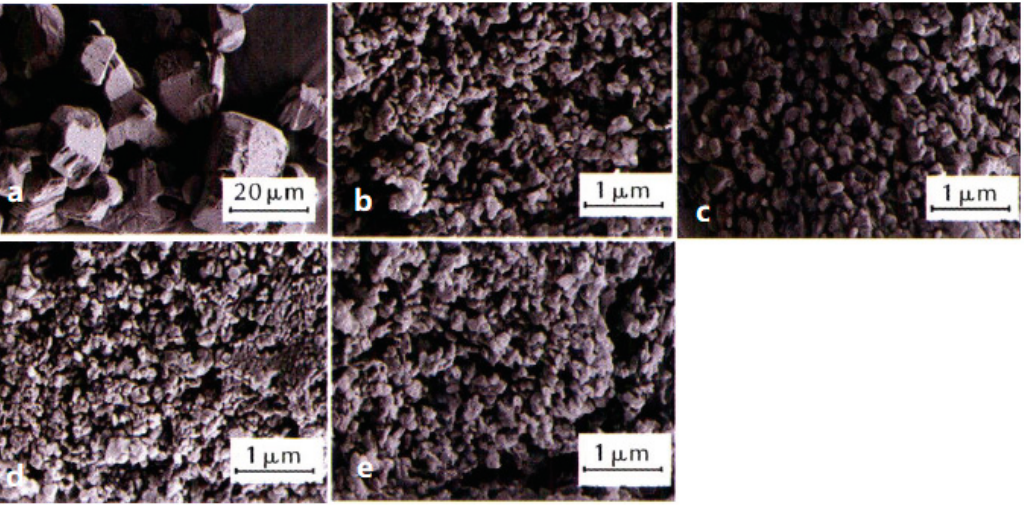
Figure 7. SEM images and average particle size of raw FOX ‐ 7 and nFOX ‐ 7 prepared in different solvents. ( a ) Raw FOX ‐ 7, d 50 = 27 μ m; ( b ) DMAC, d 50 = 0.18 μ m; ( c ) acetone, d 50 = 0.20 μ m; ( d ) NMP, d 50 = 0.14 μ m; ( e ) DMF, d 50 = 0.17 μ m. Reproduced from [56], with permission from Chinese Journal of Explosives & Propellants (Huo Zha Yao Xue Bao), 2021.